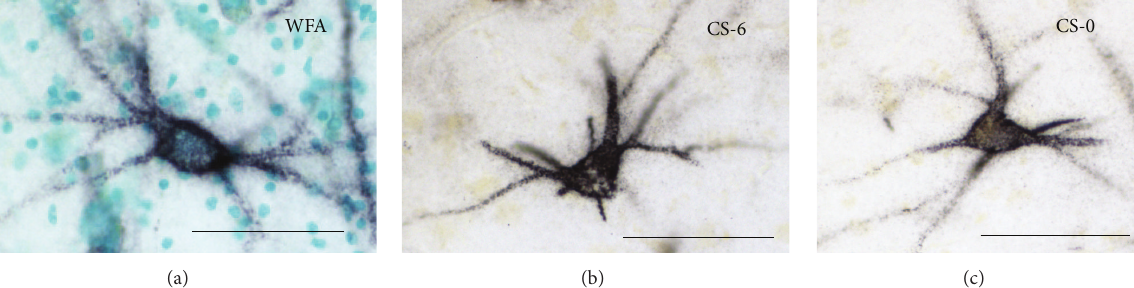
Figure 1: PNNs in the human amygdala. (a) PNN labeled with wisteria floribunda agglutinin (WFA) lectin, which binds to N-acetyl- galactosamine on the terminal end of chondroitin sulfate chains. (b) PNN immunolabeled using the mAB antibody 3B3 against native chondroitin sulfate motifs specific for chondroitin-6-sulfate (CS-6). 3B3-immunolabeled PNNs are more numerous and show a much broader distribution in the human amygdala with respect to those labeled with WFA. (c) PNN immunolabeled with mAB antibody 1B5, raised against nonsulfated chondroitin sulfate (CS-0) (3B3 and 1B5 are a generous gift from Dr. Bruce Caterson, University of Cardiff, UK). Scale bar = 50 𝜇 m.